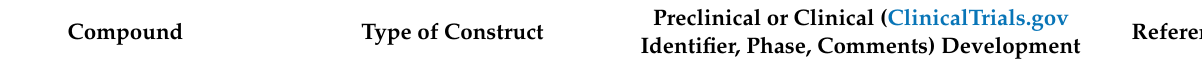
Table 2. Anti-ICPML compounds with enhanced target cell-depleting potential reported in the literature and/or in clinical